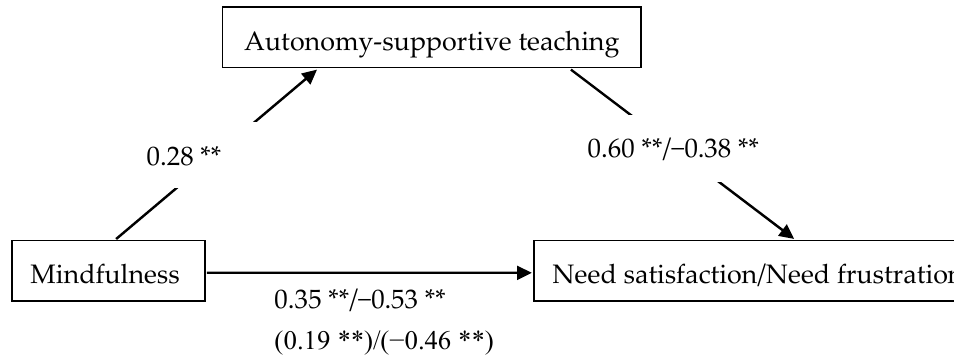
Figure 3. Standardized regression coefficients for the direct relationship between mindfulness and need satisfaction/frustration as mediated by autonomy-supportive teaching. The indirect standardized regression coefficients are represented in parentheses. ** p < 0.01.